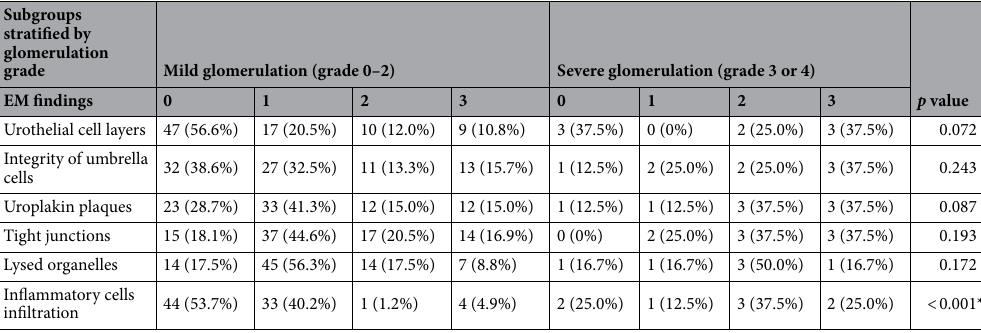
EM findings Urothelial cell layers